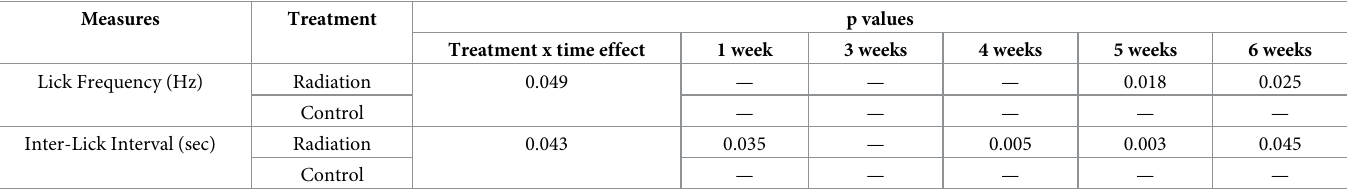
Table 3. Statistically significant differences in the time points post treatment compared to